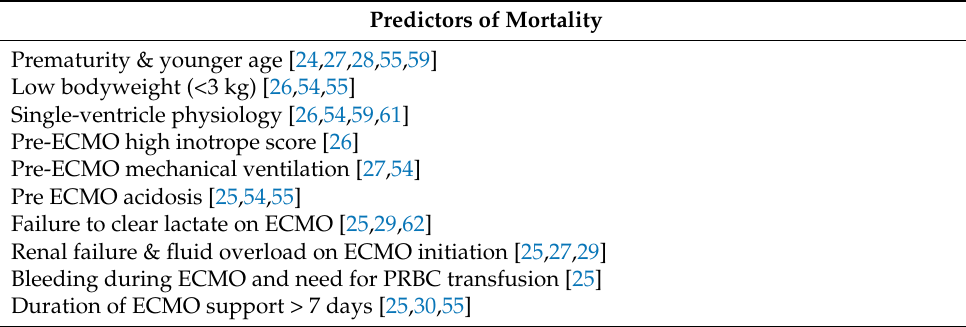
Table 3. Predictors of mortality in VA ECMO for Surgical Indications Predictors of